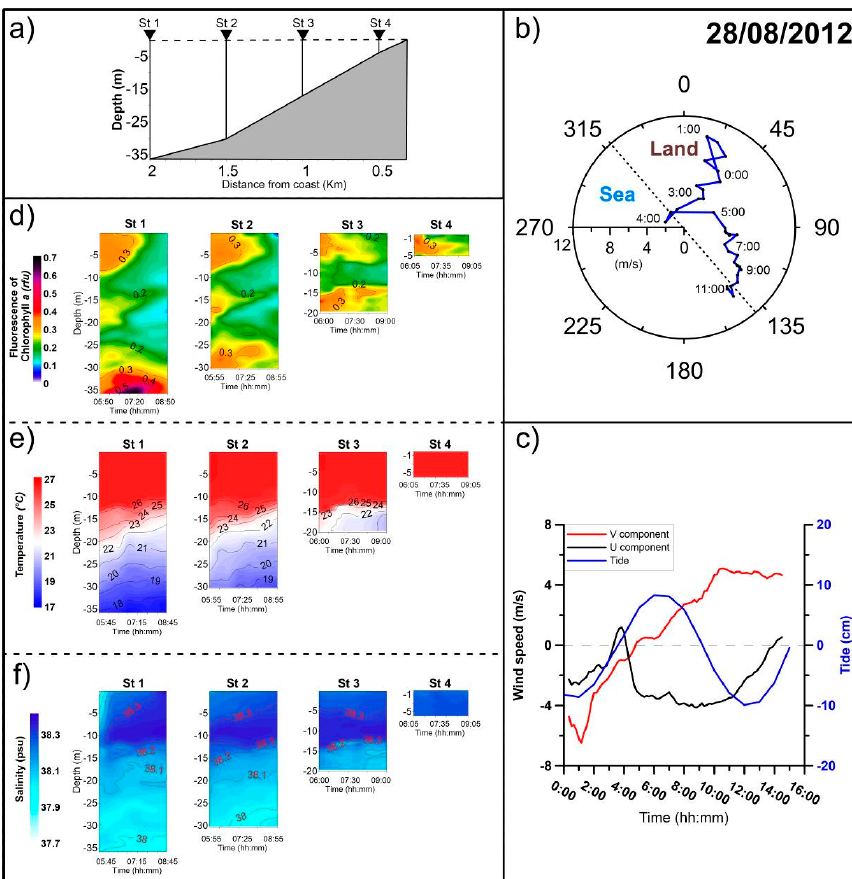
Figure 5. ( a ) Station location scheme along the transect survey. ( b ) Wind hodograph and ( c ) U (black line) and V (red line) wind components and tide (blue line) on the survey day. ( d ) Time series of chlorophyll a fluorescence, ( e ) temperature, and ( f ) salinity at all stations.